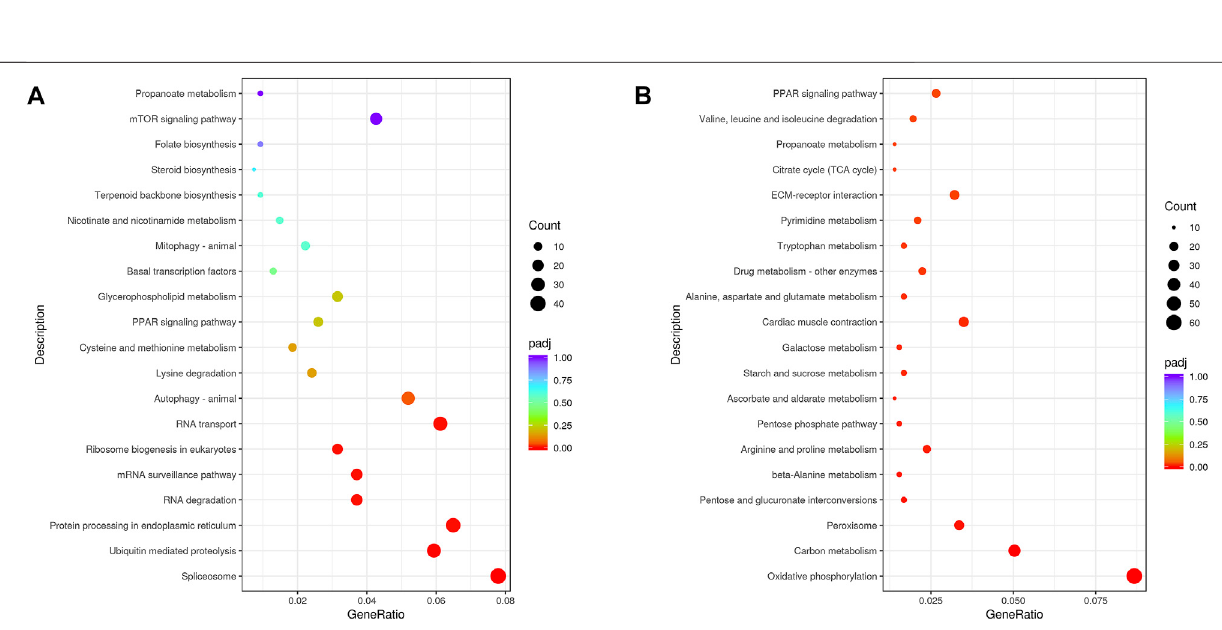
Frontiers in Genetics |